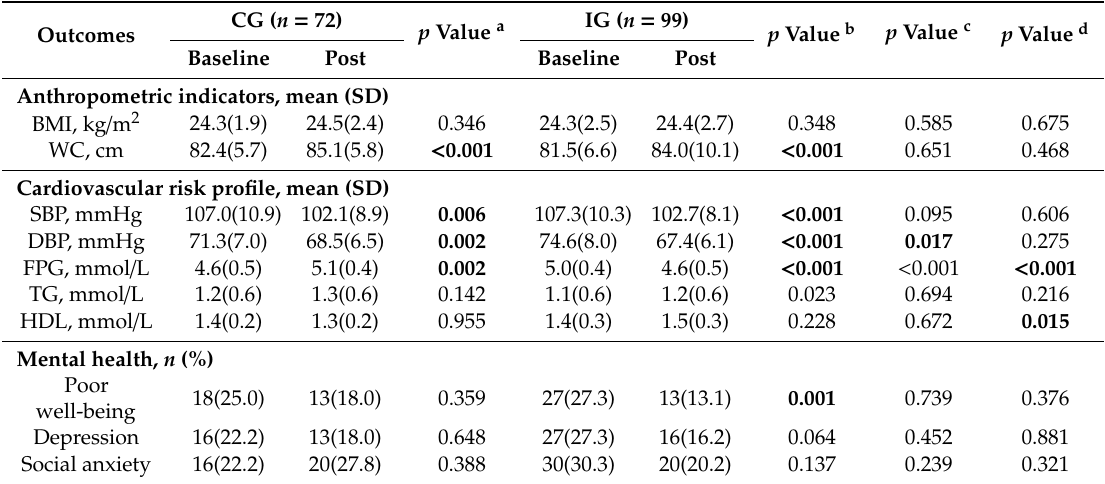
Table 3. Comparisons of di ff erent health outcomes between the control and intervention group.